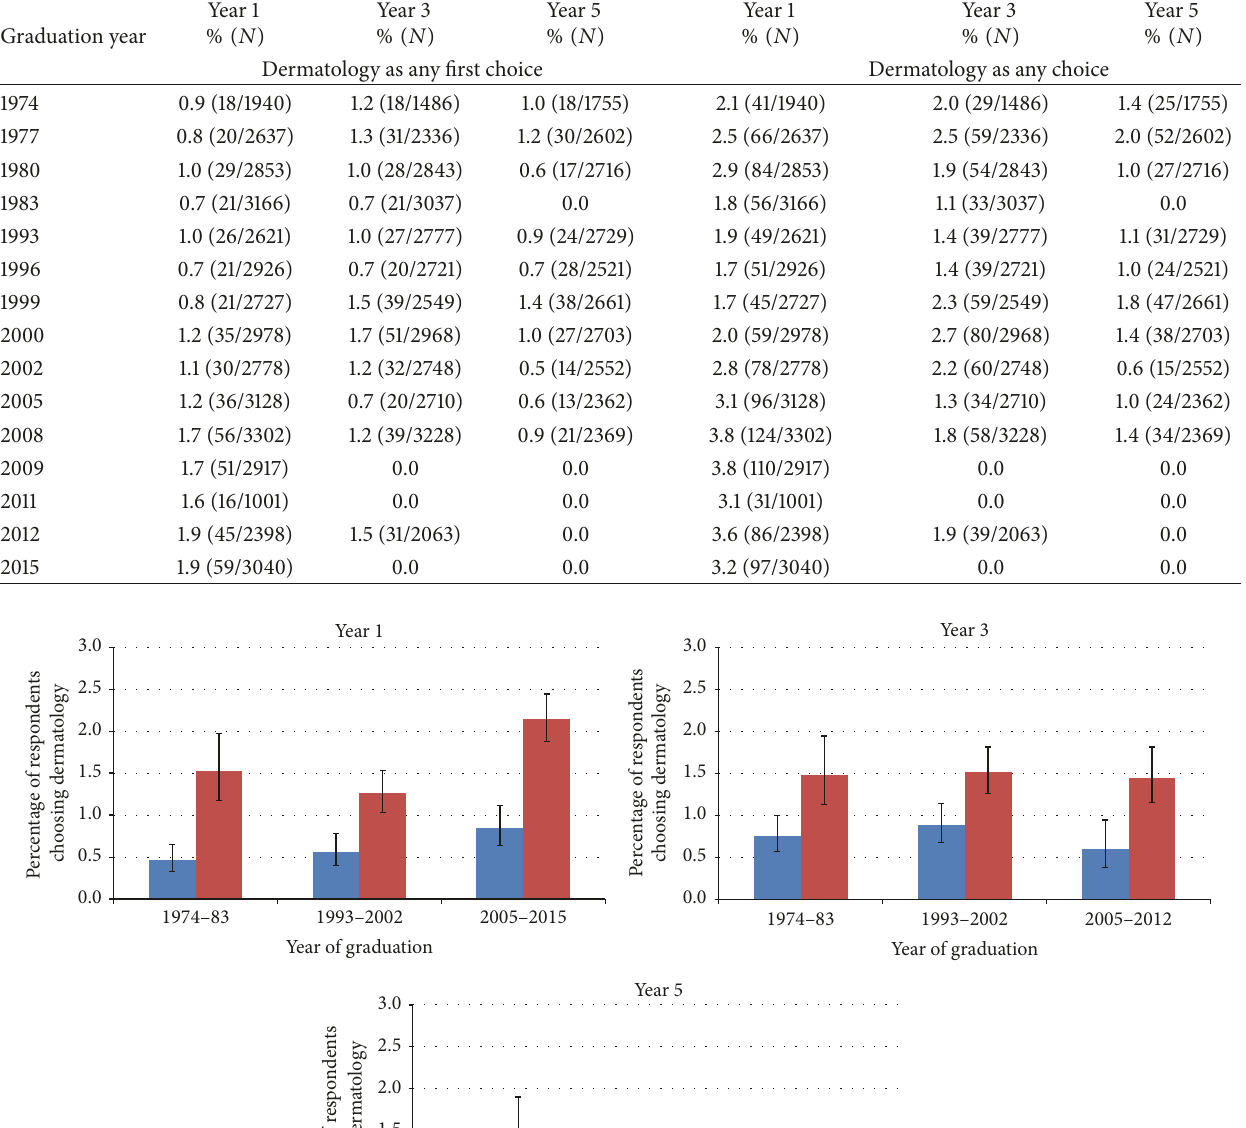
Table 2: Choices for dermatology in individual cohorts: percentages and numbers of respondents.